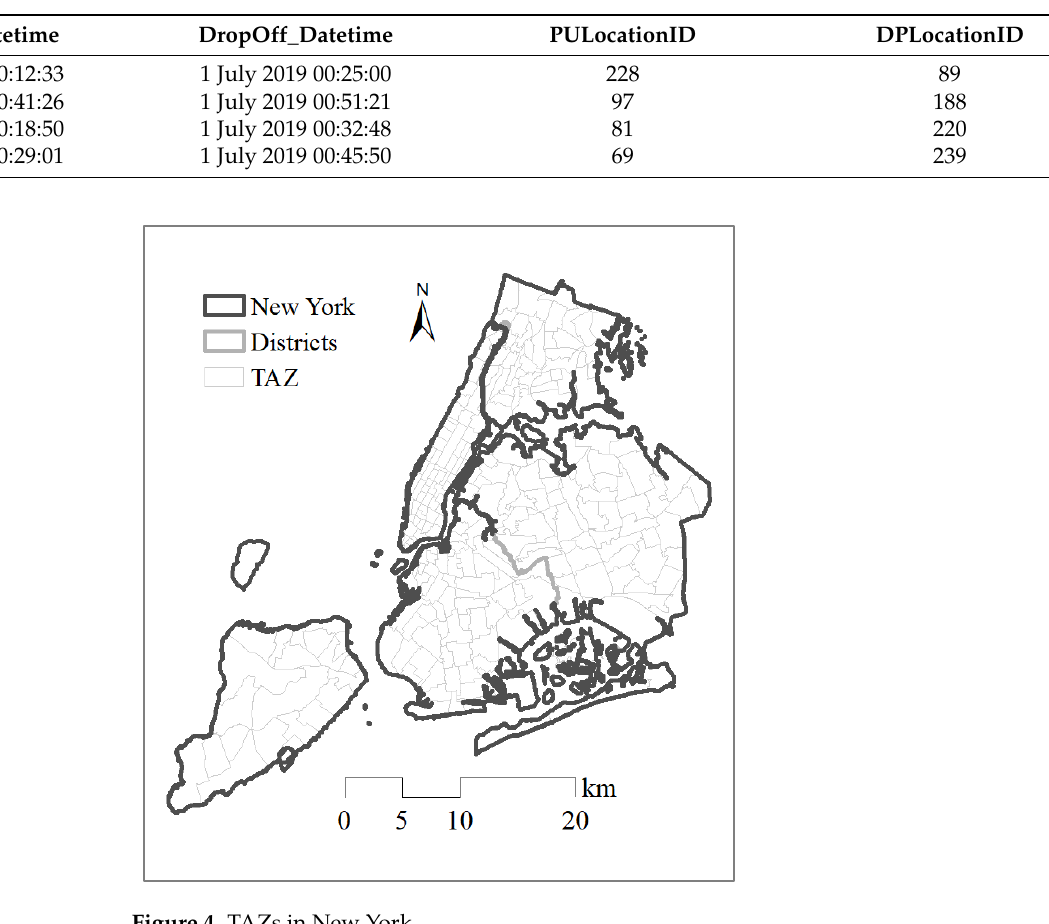
Table 2. Trip records of High Volume For-Hire Vehicle in New York City.